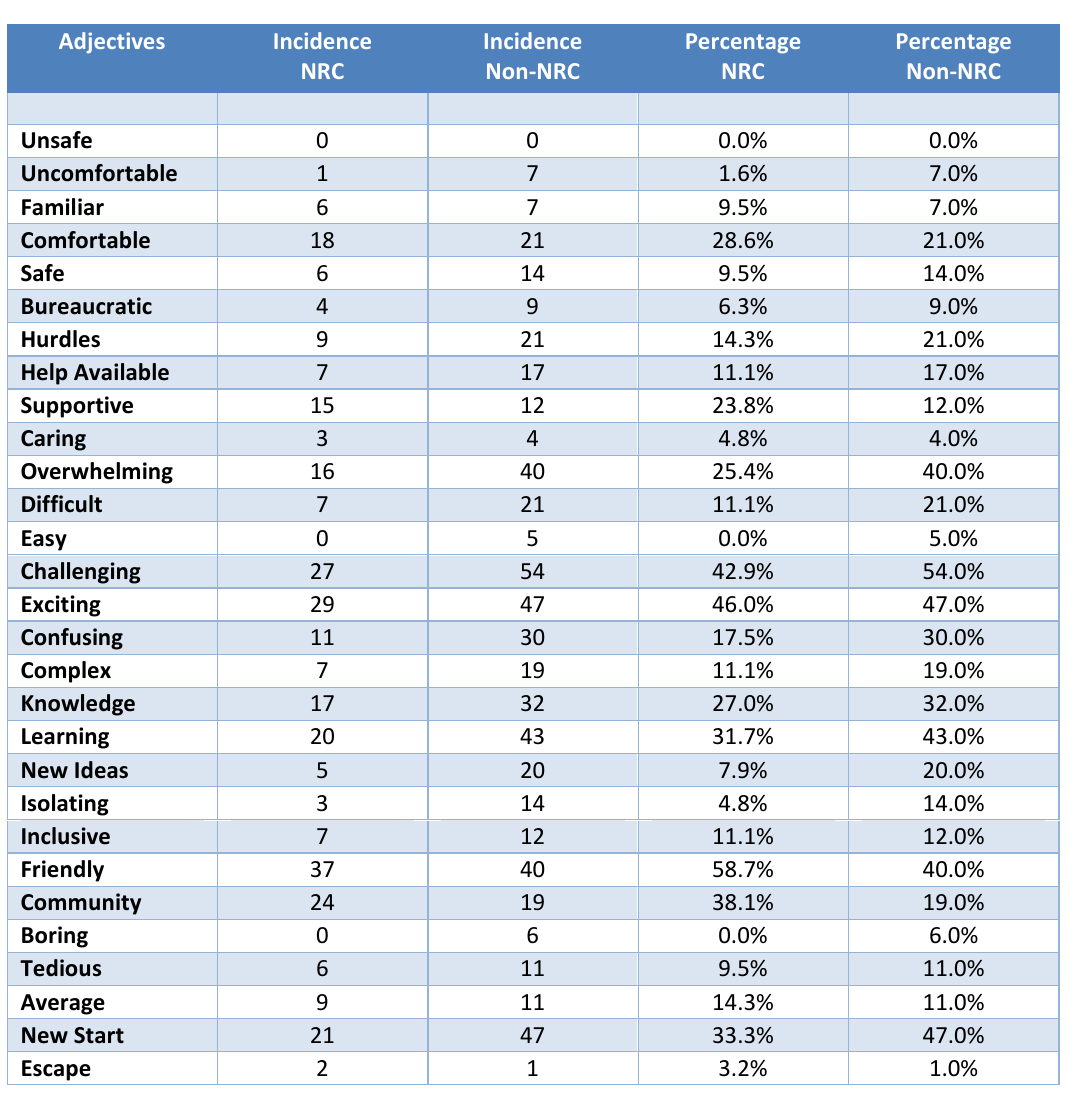
Table 3: Adjective incidence for NRC (n=63) and non-NRC (n=100) students to describe their experiences at university after the fourth week of semester